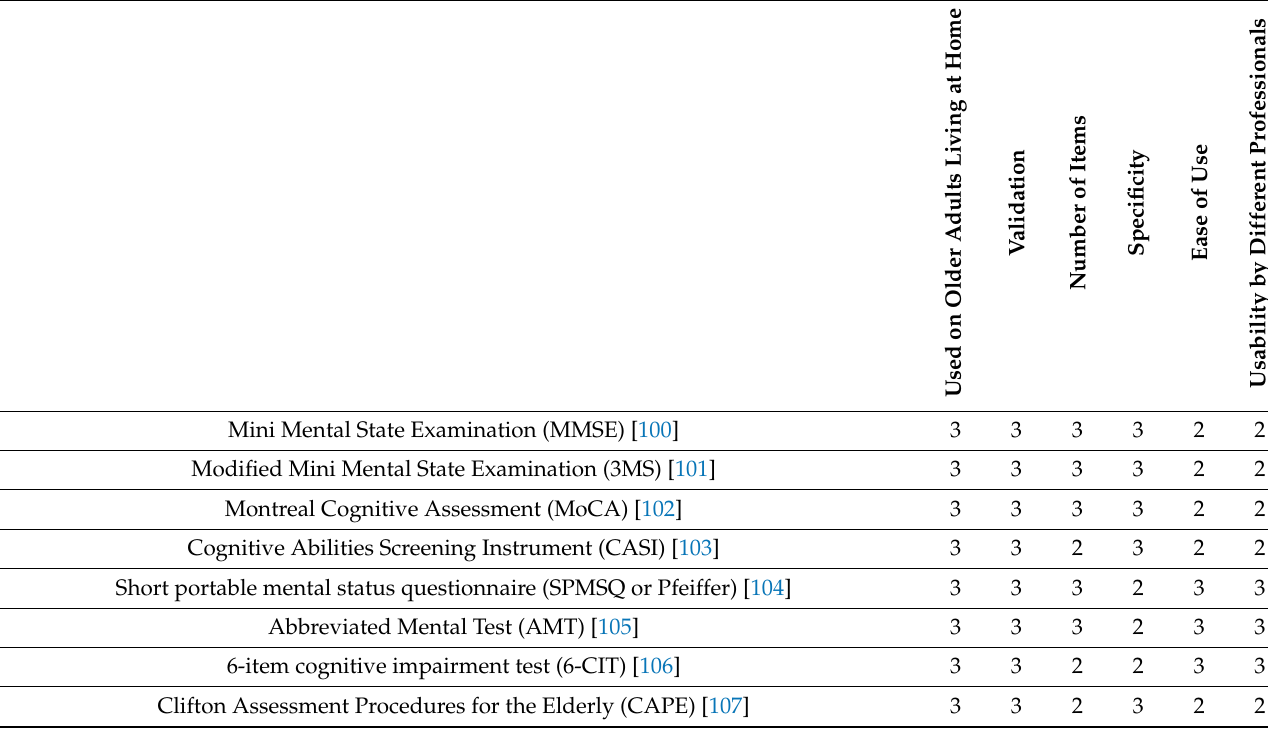
Table 6. Cognitive decline assessment tools